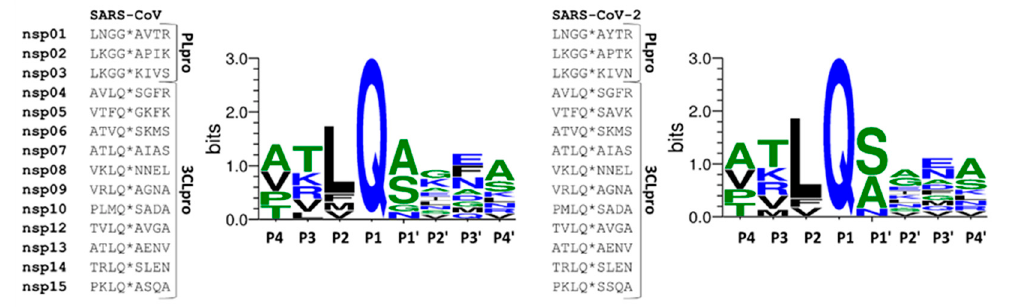
Figure 2. Comparison of SARS-CoV and SARS-CoV-2 cleavage site sequences. Sequences are shown for PLpro and 3CLpro based on literature data [15,16]. Cleavage positions are shown by asterisks, the sequences enclosed by the lines were used to prepare sequence logos. P4-P4’ substrate residues are numbered according to the nomenclature of Schechter and Berger [15].